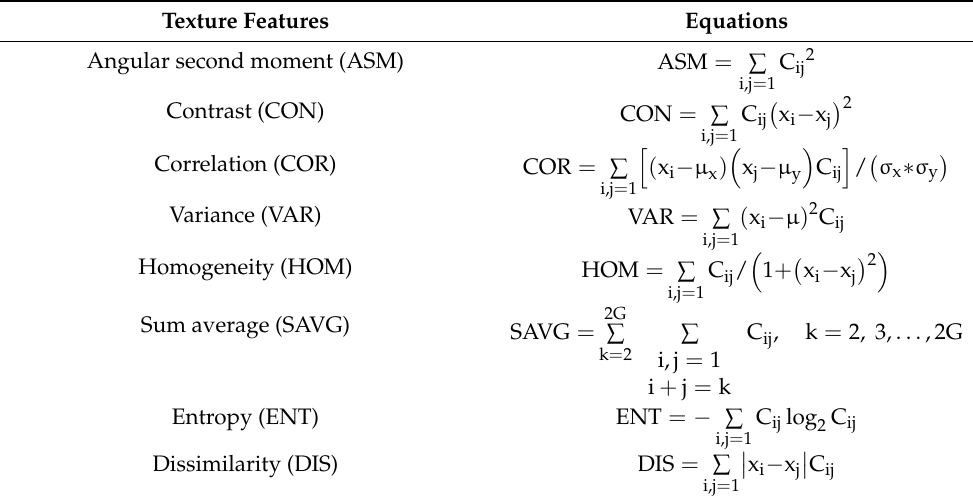
Table A2. Gray level co-occurrence texture features used in this study [37].